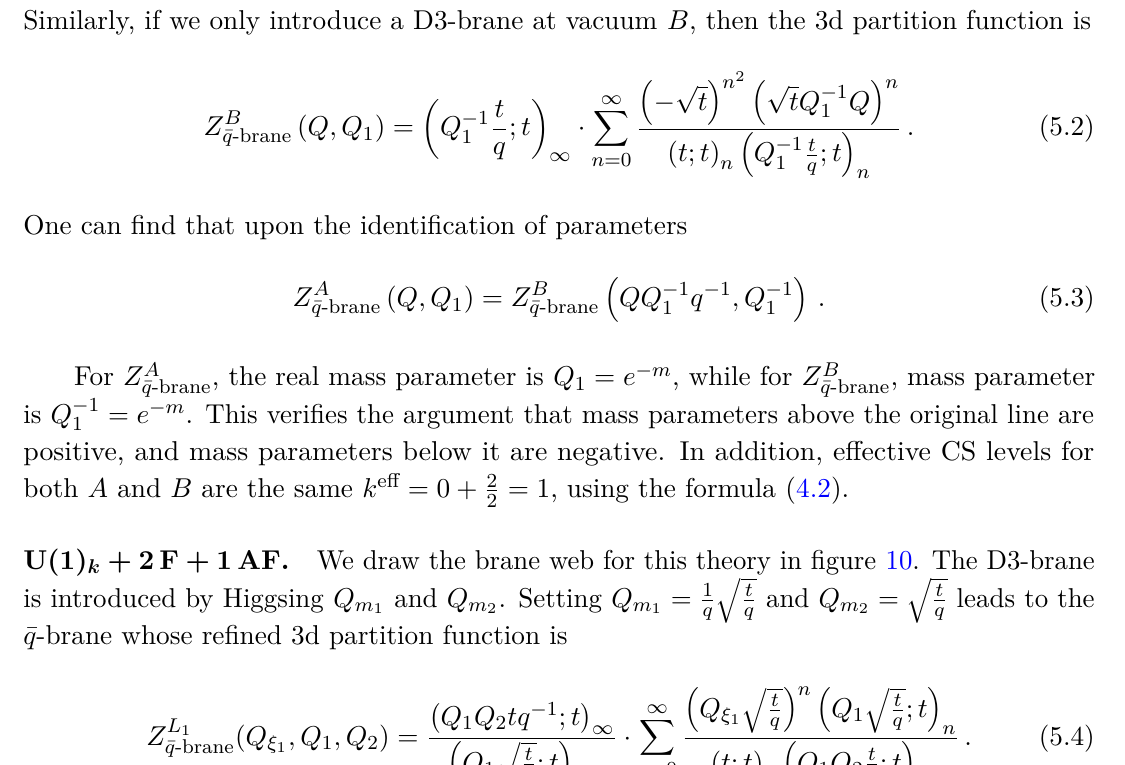
Figure 10 . We denote the D3-brane introduced by Higgsing Q m Q m as L 2 . The Kähler parameters corresponding to mass parameters have been assigned on 2 brane